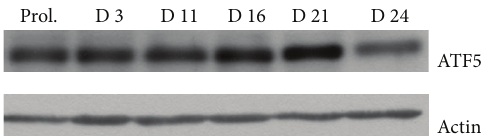
Figure 5: Western blot analysis, using human anti-ATF5 antibody, in hADSCs at specific time points (proliferation, days 3, 11, 16, 21, and